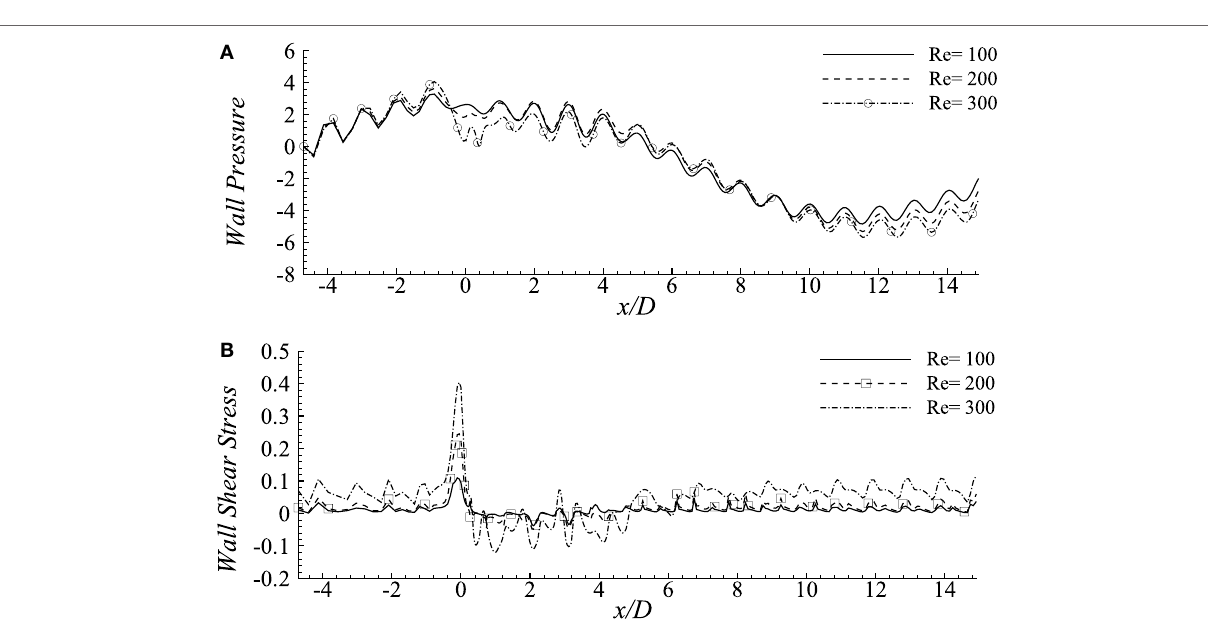
at the pre- and post-diseased segments which correspond to the results revealed by Young et al.